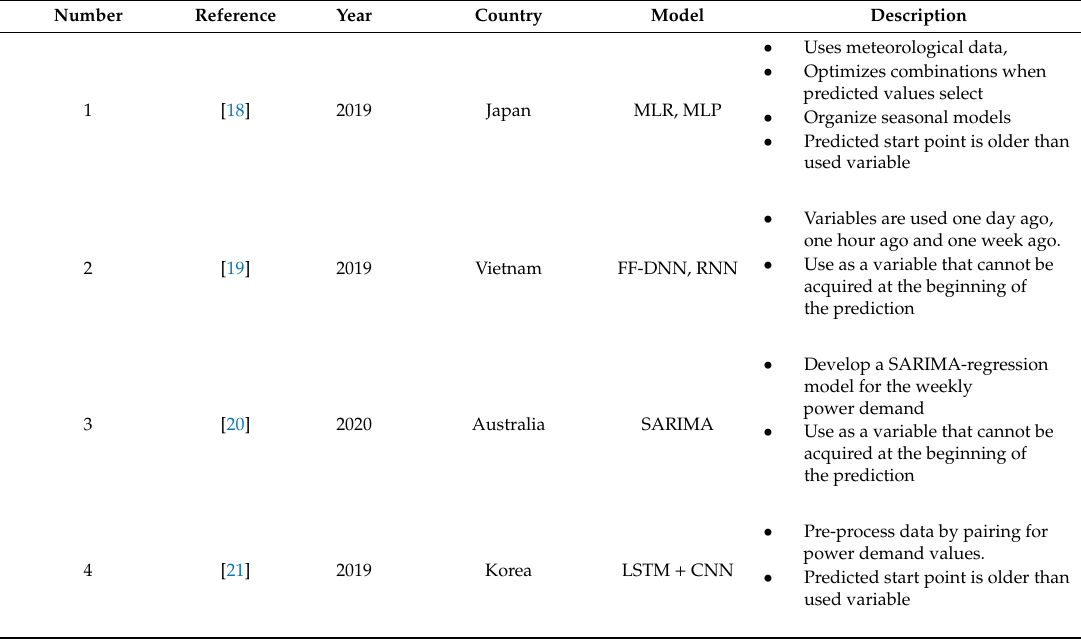
Table 2. Previous studies on the prediction of amount of